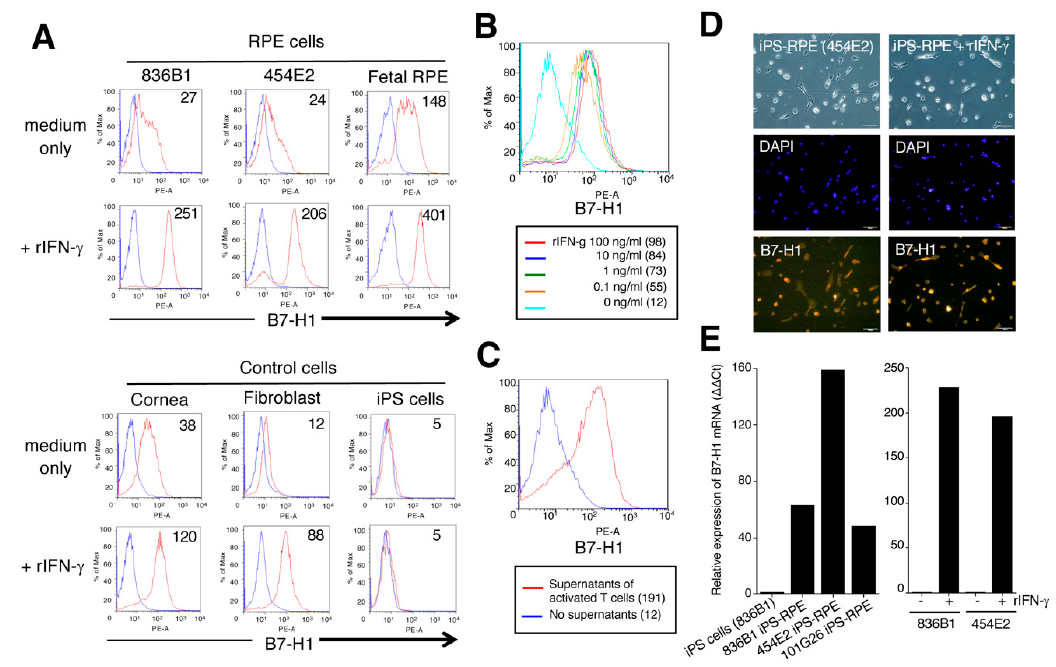
Figure 3. Expression of B7-H1 molecules on human iPS-RPE cells. The expression of B7-H1 costimulatory molecules on established iPS-RPE cells was assessed by FACS ( A, B, C ), IHC ( D ), and qRT-PCR ( E ). ( A ) iPS-RPE cells, 836B1 and 454E2, and primary fetal RPE cells as a control; lower histograms are cells with recombinant IFN- γ . In FACS analysis, human corneal endothelial cells (Cornea) and fibroblast and control human iPS cells (454E2 line) were also prepared. Blue histogram: data for isotype control. The number in the histogram indicates mean fluorescence intensity (MFI). ( B ) Dose-response assays with recombinant IFN- γ used 0, 0.1, 1.0, 10, and 100 ng / mL. The numbers in parentheses indicate MFI. ( C ) We also prepared iPS-RPE cells exposed to supernatants collected from activated T cells from a VKH uveitis patient (red histogram). Blue histogram: no supernatants (control). The numbers in parentheses indicates MFI. ( D ) For IHC, we also prepared 454E2 iPS-RPE cells with or without recombinant IFN- γ . The expression of B7-H1 is shown in red, and middle pictures show cell nuclei counterstained with DAPI. Scale bars, 100 µ m. ( E ) The expression level of B7-H1 mRNA in iPS-RPE cells, 836B1, 454E2, 101G26, and control iPS cells (836B1) is shown. The right panel indicates iPS-RPE cells (836B1, 454E2) with or without recombinant IFN- γ . Results indicate the relative expression of B7-H1 ( ∆∆ Ct: control iPS cells =